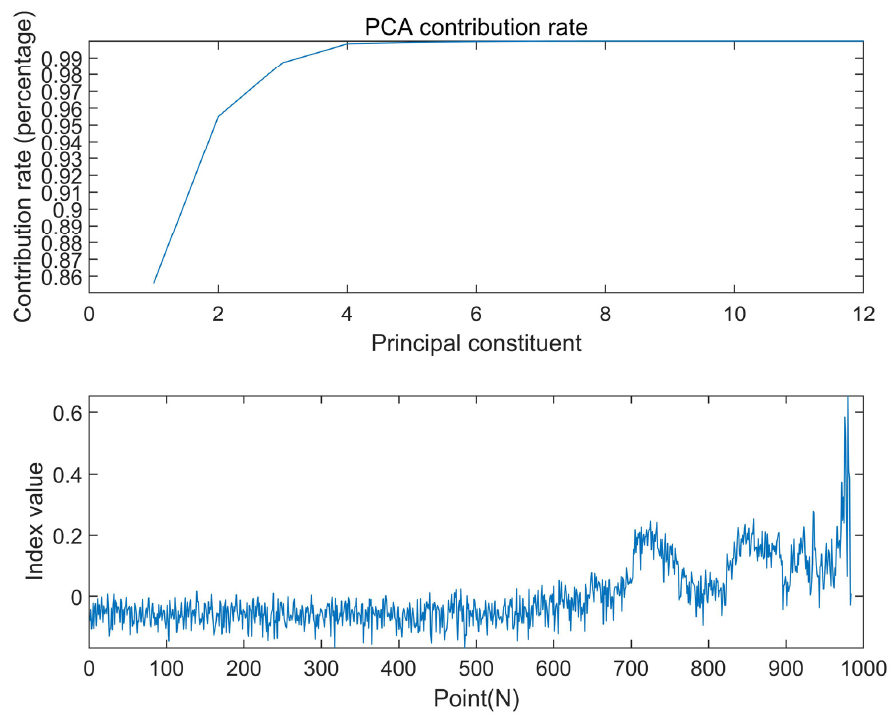
Figure 4. PCA index of bearing